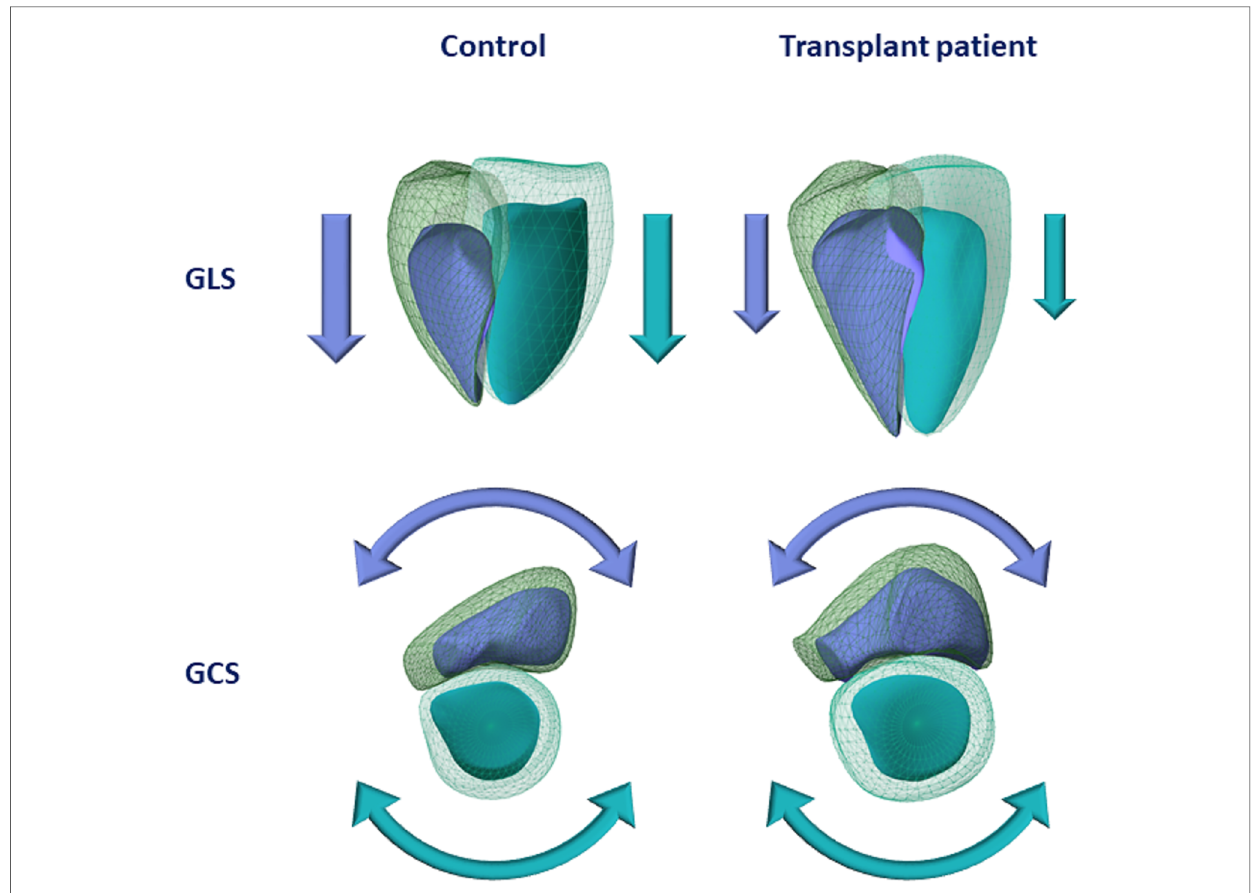
FIGURE 3 Graphical representation of a healthy control and a kidney transplant recipient in terms of three-dimensional left and right ventricular volumes and mechanics. The transplant patient shows larger left and right ventricular end-diastolic and end-systolic volumes compared with the healthy control (light turquoise mesh — left ventricular end-diastolic volume; dark turquoise surface — left ventricular end-systolic volume; green mesh — right ventricular end-diastolic volume; blue surface — right ventricular end-systolic volume). Concerning systolic function, both left and right ventricular global longitudinal strain values showed visible decrease in the transplant patient, whereas left and right ventricular global circumferential strain values were found to be comparable between the two subjects. GLS, global longitudinal strain; GCS, global circumferential strain.